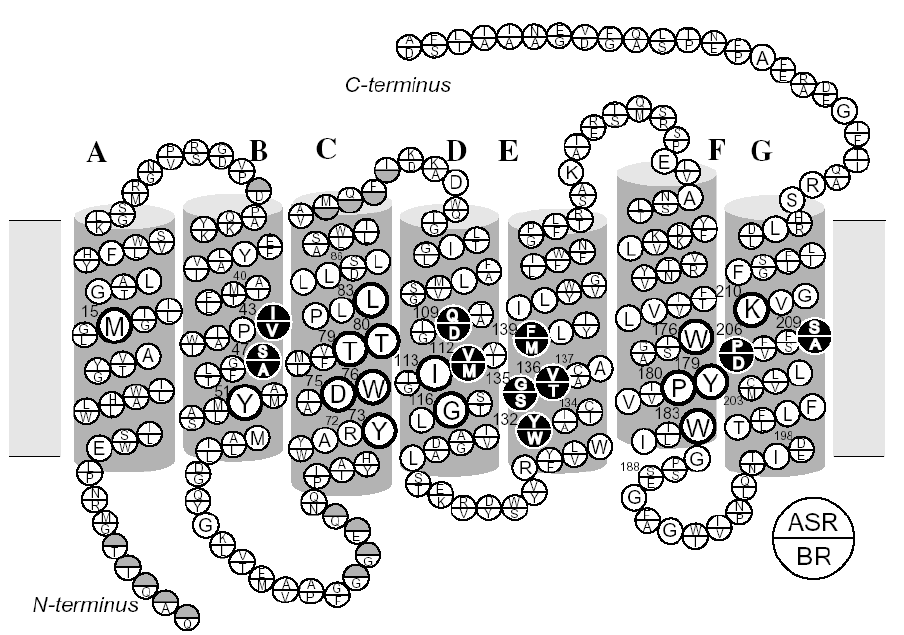
Figure 5. Comparison of amino acid sequences of ASR and BR. The transmembrane topology is based on the crystallographic three-dimensional structures. The sequence alignment was done using CLUSTAL W [21] with the default settings. Single letters in a circle denote residues common to ASR and BR. The residues that are different in ASR and BR are denoted at the top and bottom of the circles, respectively. The residues forming the retinal binding site within 5 Å of the chromophore are shown by bold or filled circles. This figure is reprinted with permission from Furutani et al. [20]. Copyright 2005 American Chemical